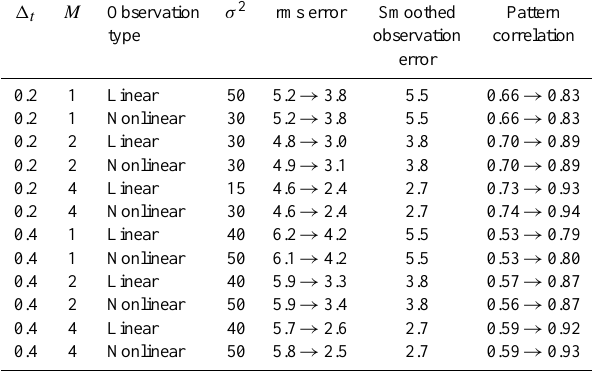
Table 1. Results of the assimilation experiments for regime I. There Table 2. Results of the assimilation experiments for regime II. are P = MK equispaced observations, assimilated at time intervals There are P = MK equispaced observations, assimilated at time in- of (cid:49) t , and σ 2 is the amplitude of the background covariance matrix. tervals of (cid:49) t , and σ 2 is the amplitude of the background covariance For comparison, the climatological rms error and pattern correlation matrix. For comparison, the climatological rms error and pattern are 5.6 and 0.57. correlation are 5.7 and 0.53. (cid:49) t M Observation σ 2 rms error Smoothed Pattern Pattern type type observation correlation